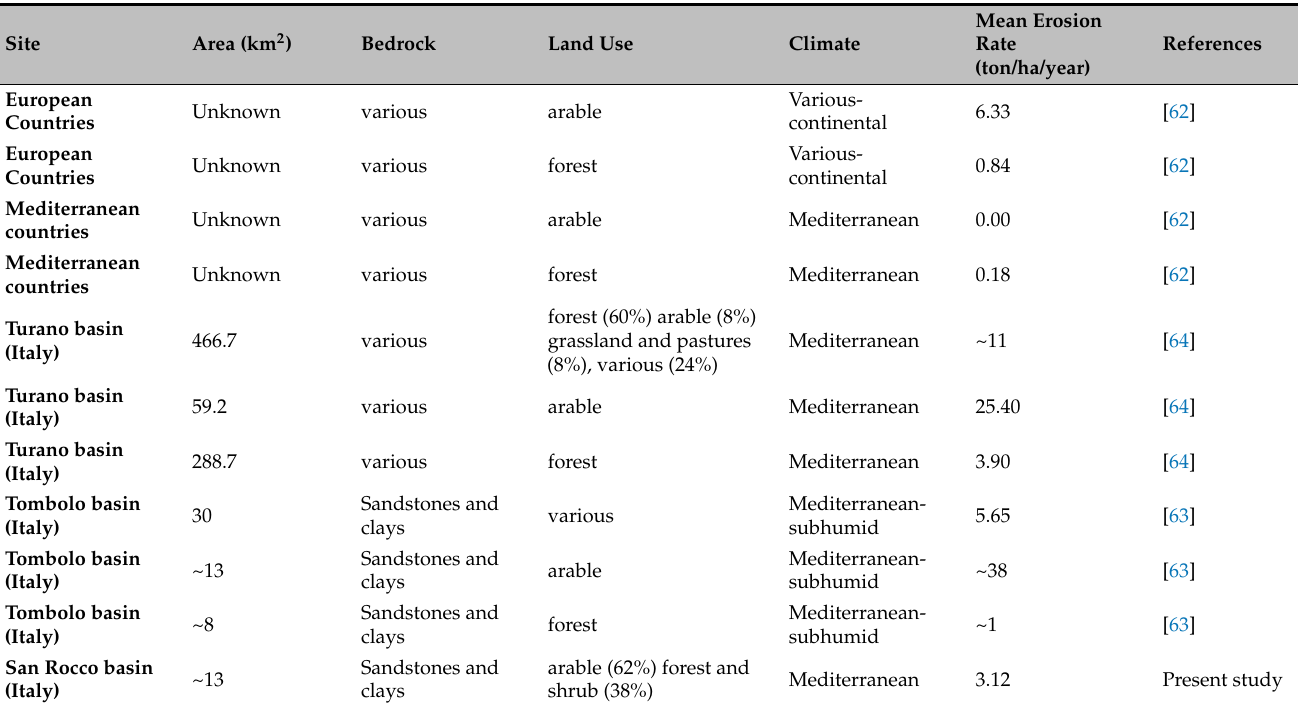
Table 7. Comparison of erosion rates (weighted mean) for different land uses and different study sites (Mediterranean area, European countries, and the present